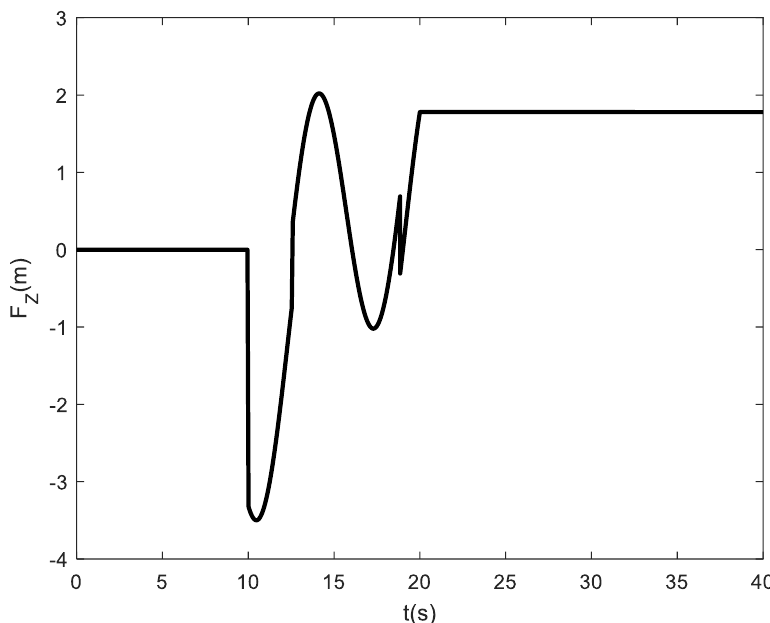
Figure 4. The curve of the disturbance in position Y channel.